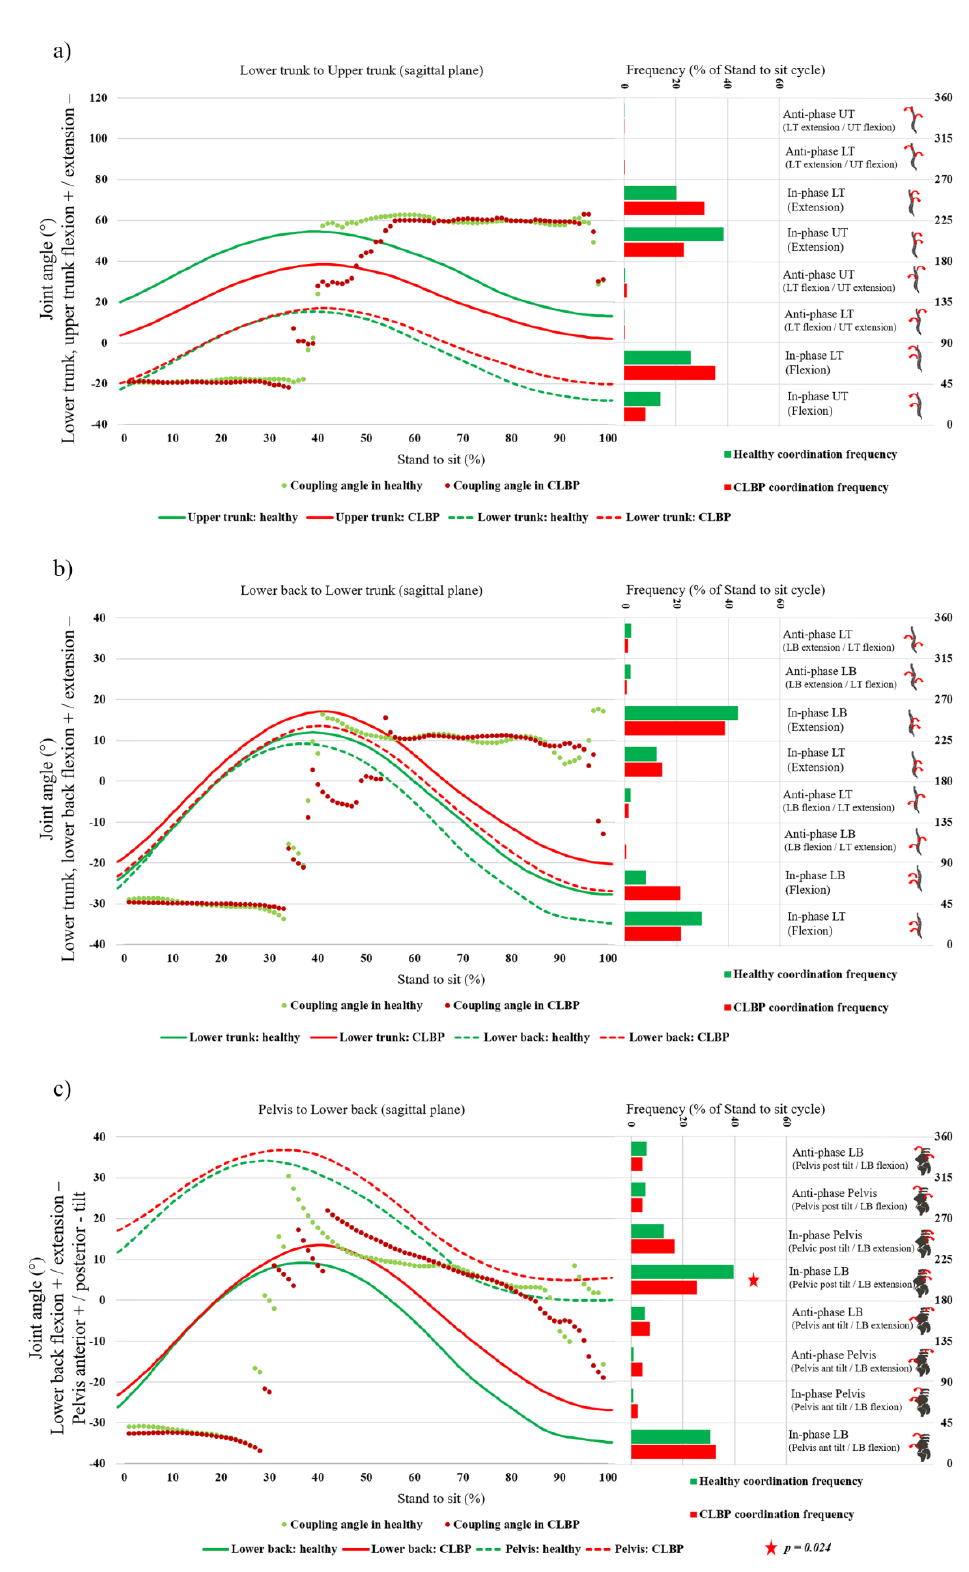
Figure 4. ( a ) LT/UT, ( b ) LB/LT, and ( c ) pelvis/LB segments angular displacement diagram in the sagittal plane, and the results of the coupling angle frequency during